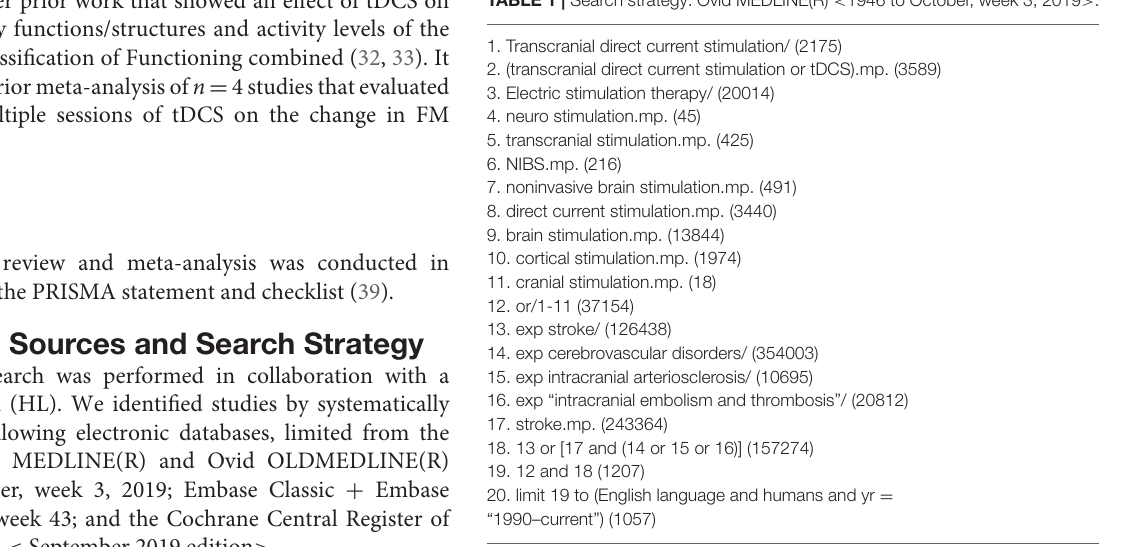
TABLE 1 | Search strategy: Ovid MEDLINE(R) < 1946 to October, week 3, 2019 >